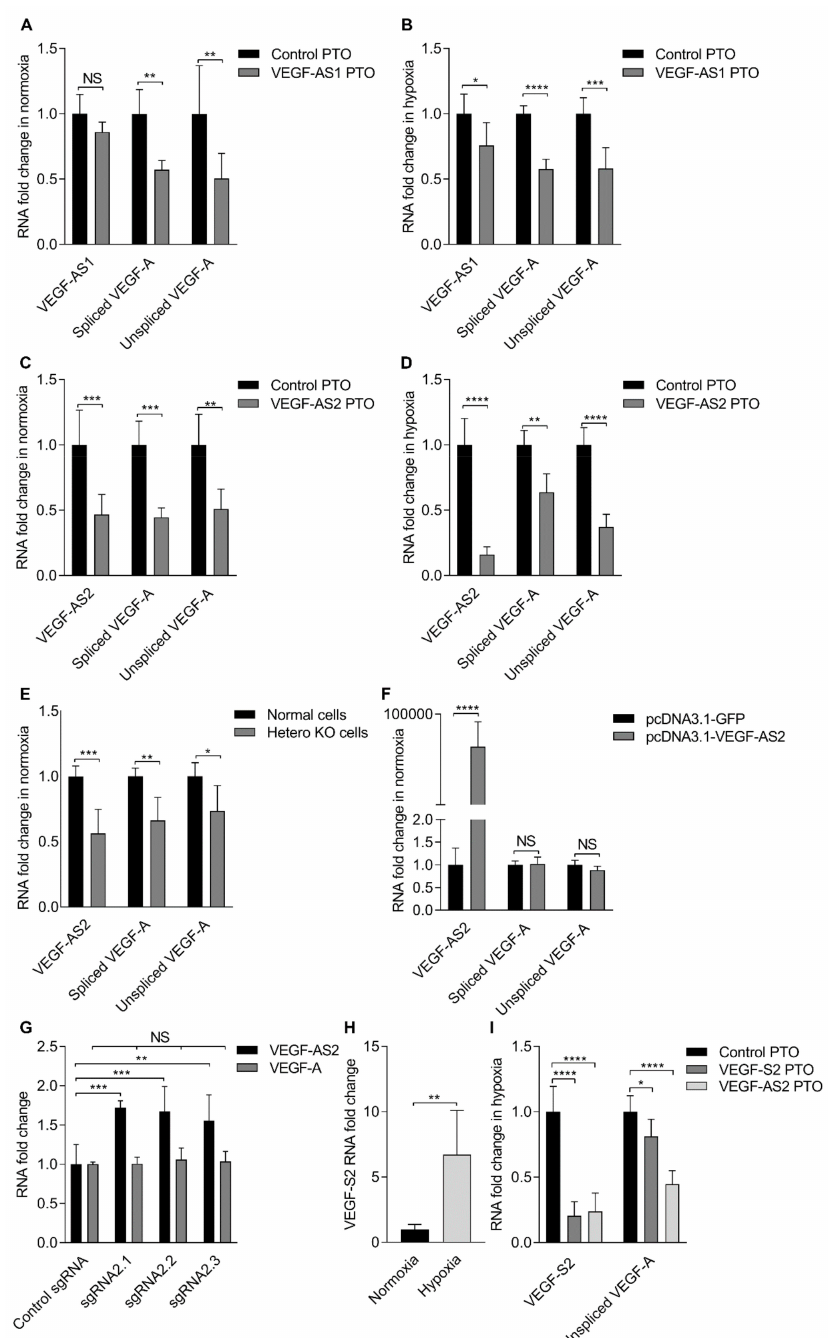
Figure 2. Repression of VEGF-A promoter associated antisense lncRNAs results in the downregulation of VEGF-A expression. ( A ) Fold change in VEGF-AS1 and spliced or unspliced VEGF-A expression levels in normoxic EA.hy926 cells 48 h after antisense phosphorothioate oligonucleotides (PTO) transfections as determined by qRT-PCR and standardized to B2M . The data are presented as mean ± SD ( n = 3 independent experiments). Significance was measured by two-way ANOVA. ** p < 0.01; ( B ) fold change in VEGF-AS1 and spliced or unspliced VEGF-A expression levels in hypoxic EA.hy926 cells 48 h after antisense PTO transfections as determined by qRT-PCR and standardized to B2M . The data are presented as mean ± SD ( n = 3 independent experiments). Significance was measured by two-way ANOVA. * p < 0.05, *** p < 0.001, **** p < 0.0001; ( C ) Fold change in VEGF-AS2 and spliced or unspliced VEGF-A expression levels in normoxic EA.hy926 cells 48 h after antisense PTO transfections as determined by qRT-PCR and standardized to B2M